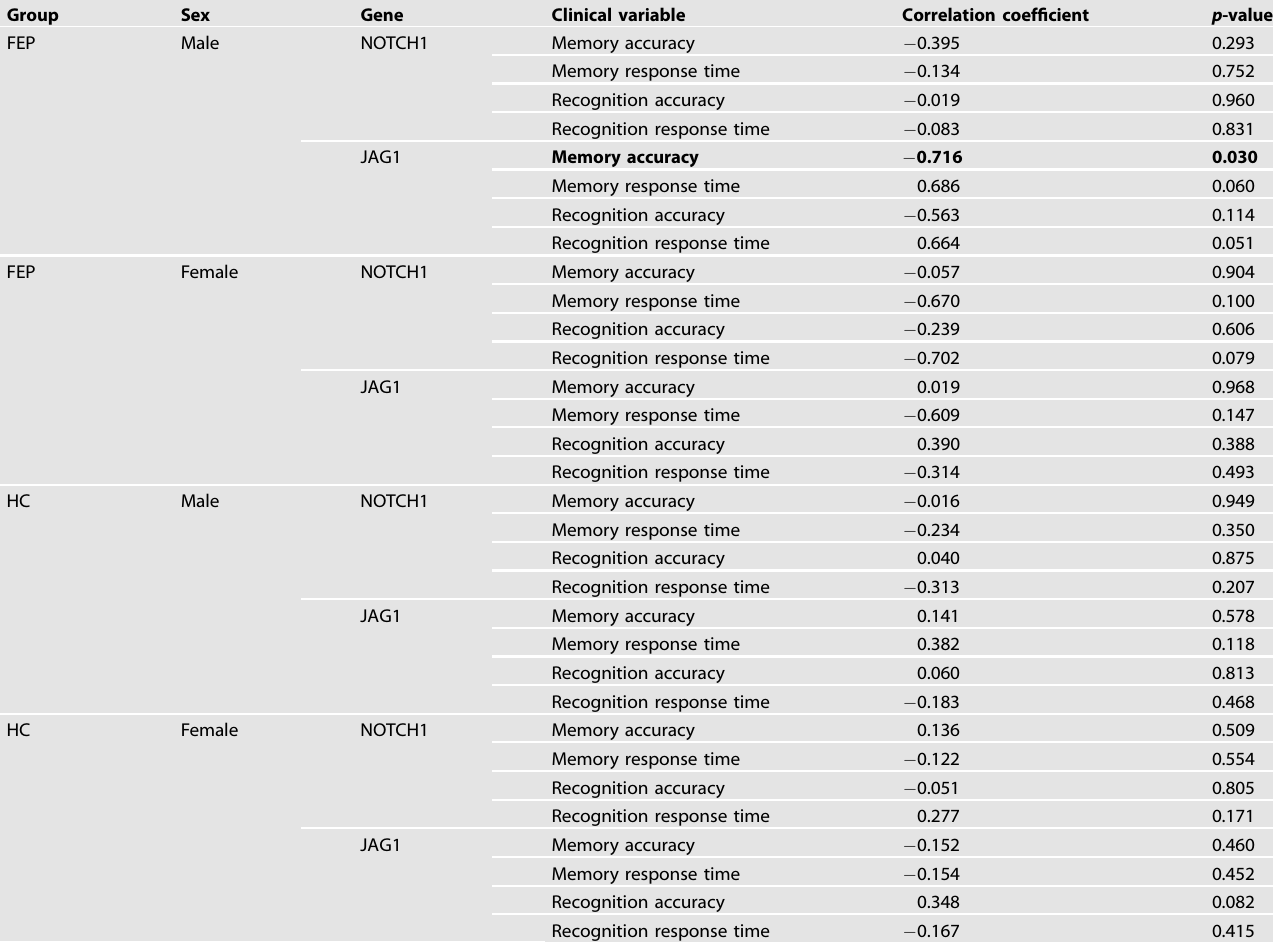
Table 3. Correlation of JAG1 and NOTCH1 expression with emotional face processing measures in the FEP cohort.